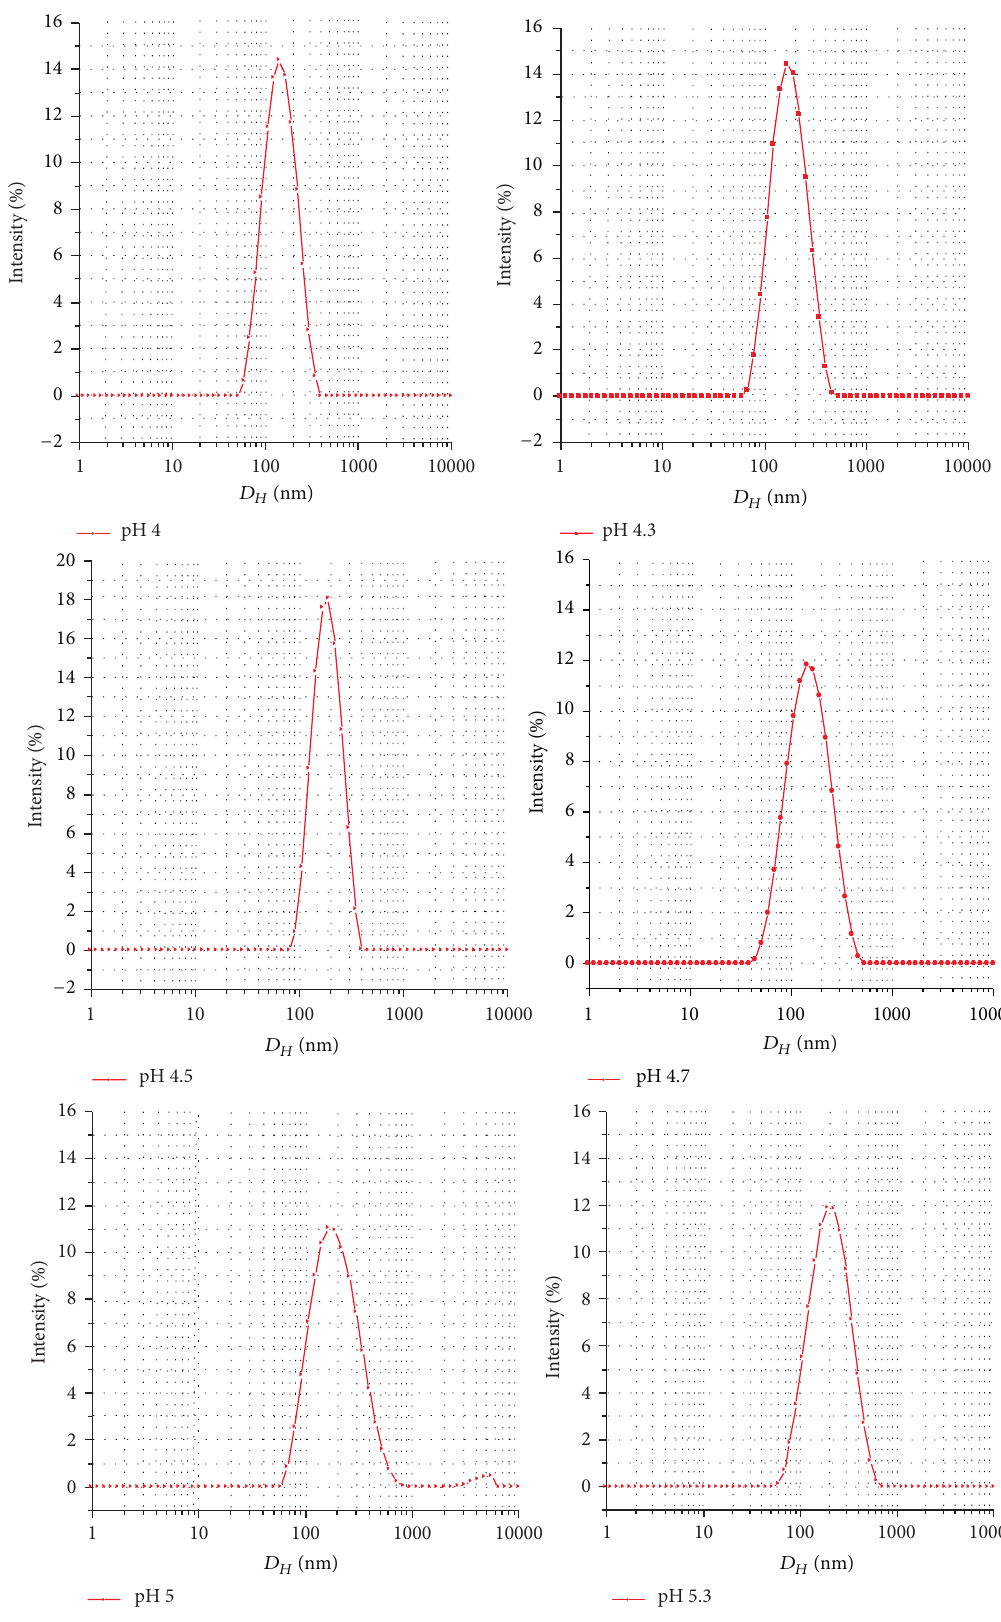
Figure 7: Particle size distribution of chitosan SH/TPP nanoparticles prepared at pH 4, 4.3, 4.5, 4.7, 5, and